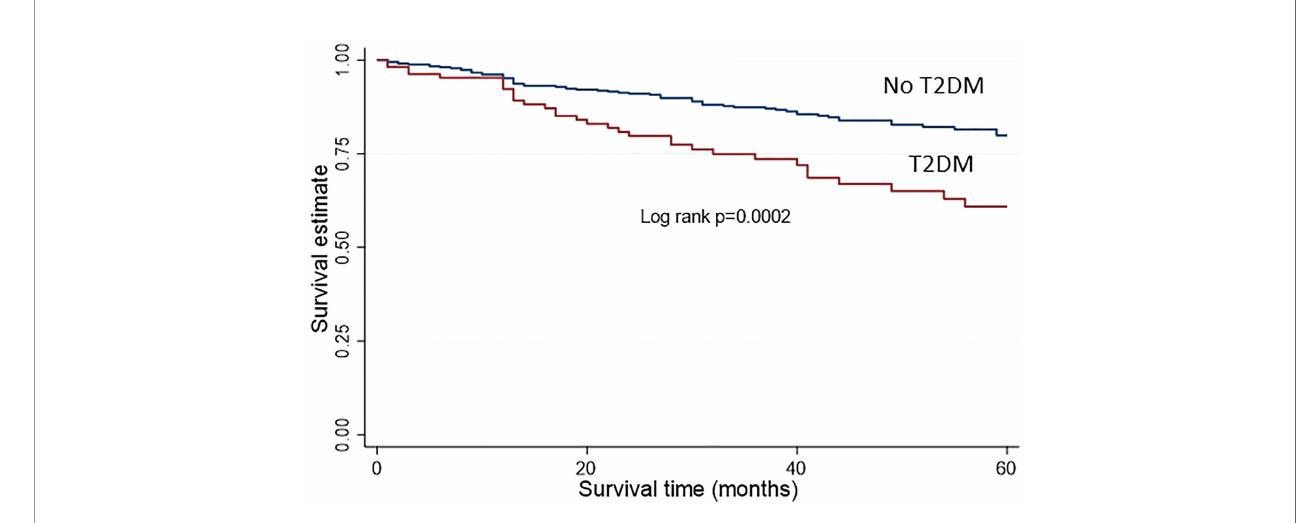
FIGURE 1 | Kaplan Meier survival analysis for overall